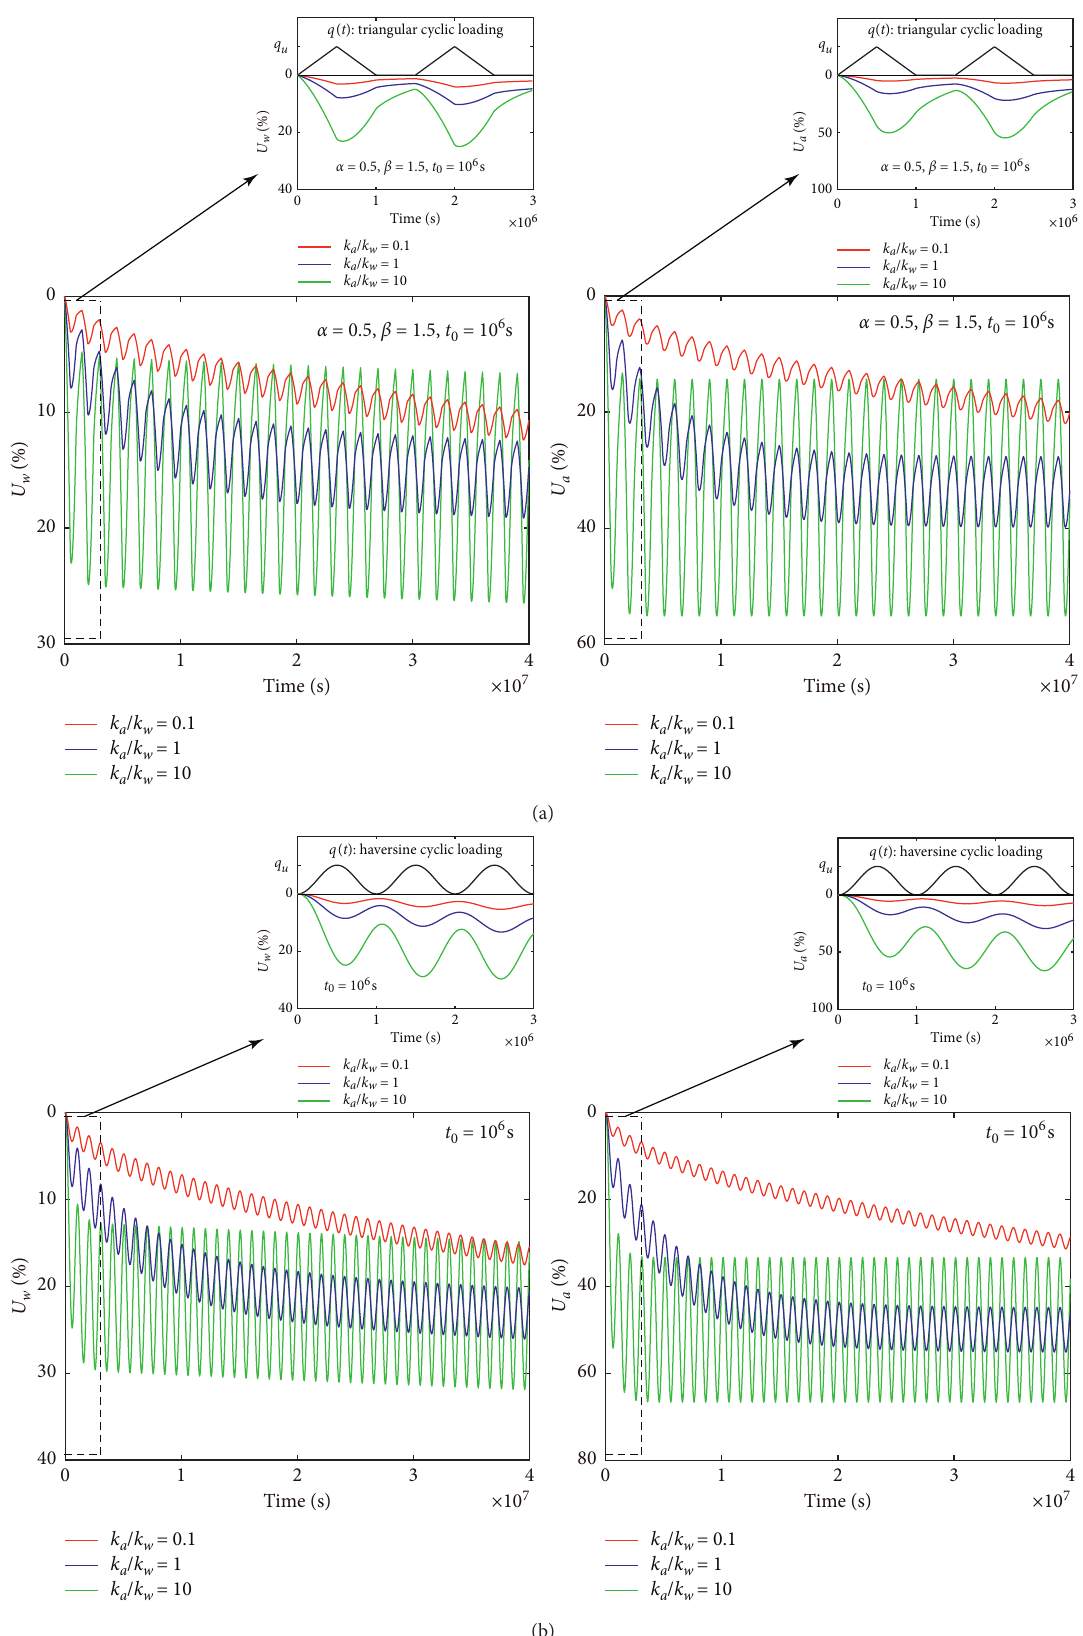
Figure 8: The effects of k k a / w on consolidation of unsaturated soils under triangular cyclic loading (a) and haversine cyclic loading